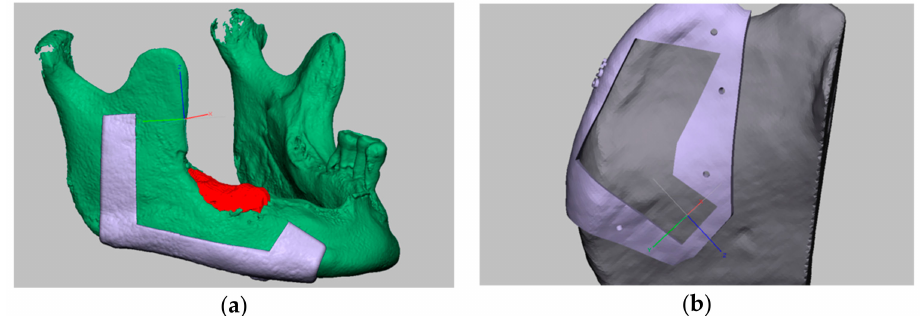
Figure 2. Computer-based planning and design of surgical guides: ( a ) Planning and computer-assisted design of the surgical guide for the mandibulectomy; ( b ) Planning and computer-assisted design of the surgical guide for the iliac crest bone flap.